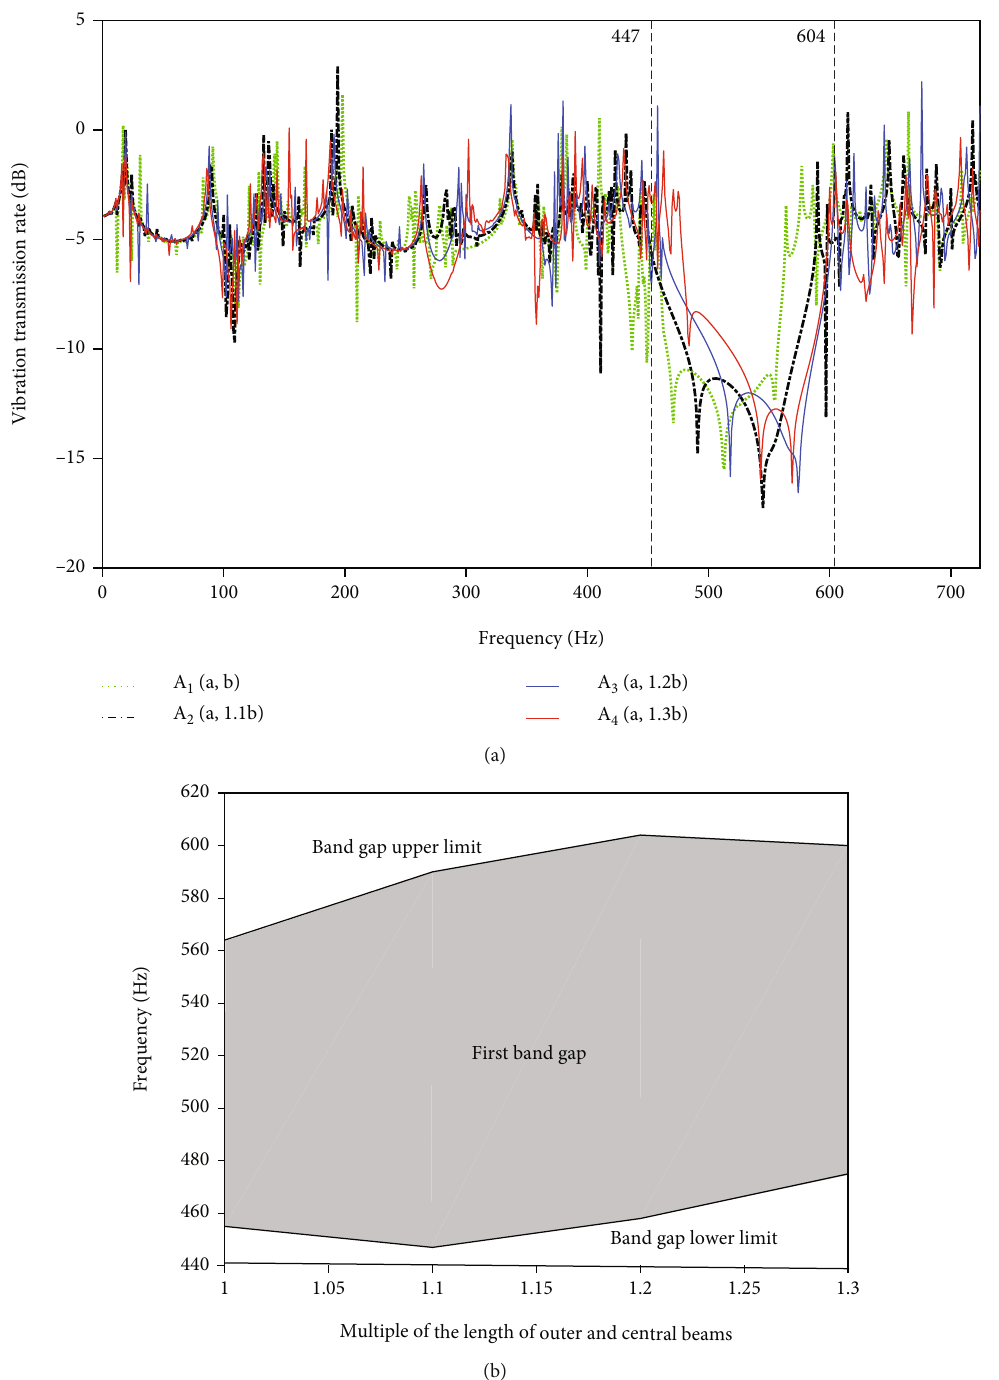
Figure 13: Corresponding to the change of the length of outer beams and center beams: (a) vibration transmission rate of node R ; (b) the fi rst band